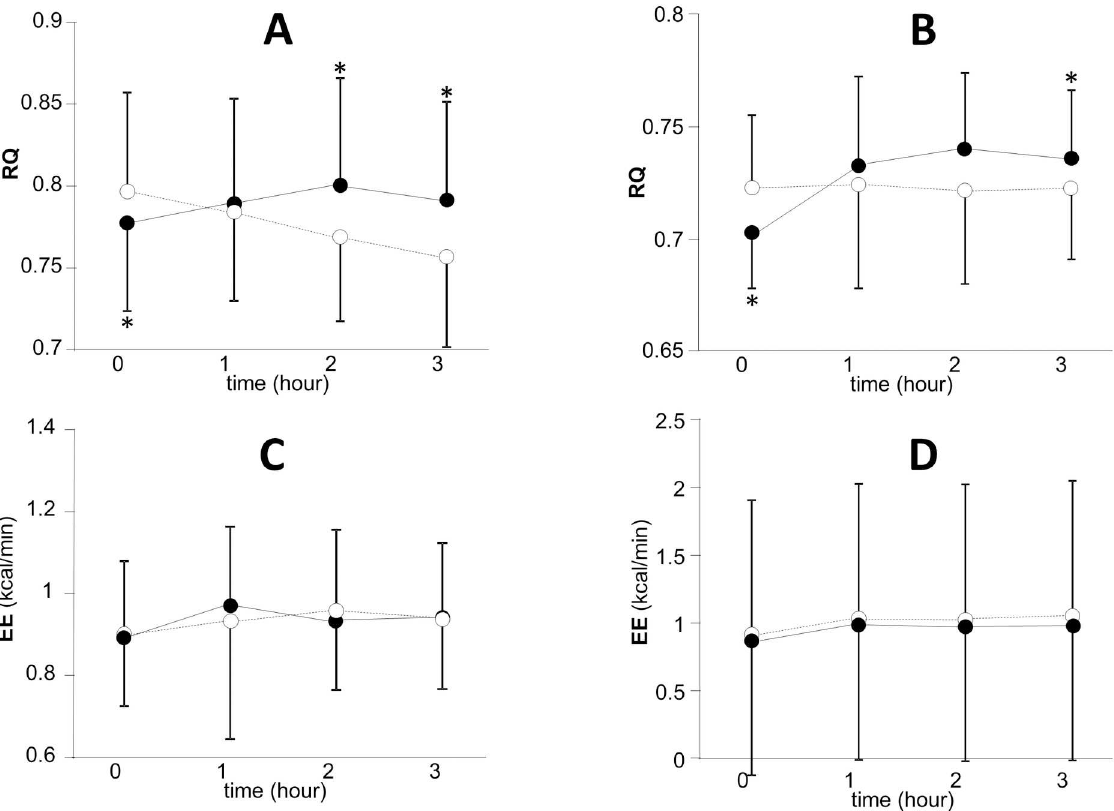
Fig 2. Effects of metformin on respiratoryquotient (RQ) and energy expenditure (EE) in healthy subjects (A and C) and diabetic patients (B and D). A, B; RQ, C, D; EE. Data are presented as mean ± S.D. Paired t-test was used for the comparison betweengroups. Open circle and dotted line; before metformin treatment, closed circle and solid line; after a 2-week treatment by metformin. * P < 0.05vs. the value before metformin treatment.